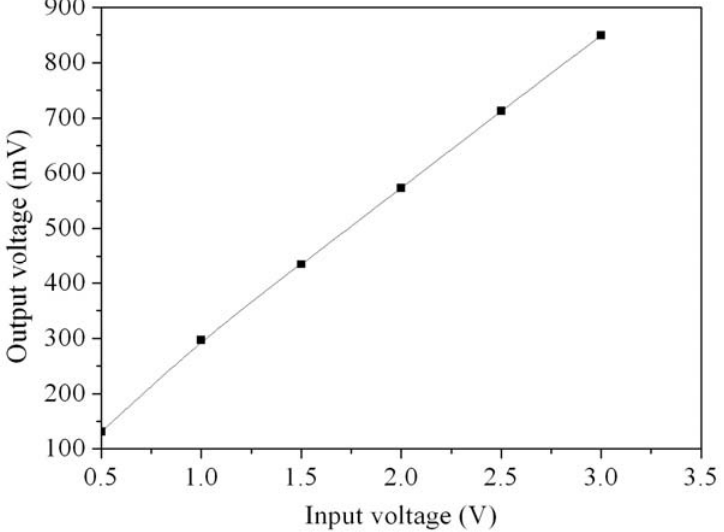
Figure 6. Relation between the output and input voltages for the readout circuit.